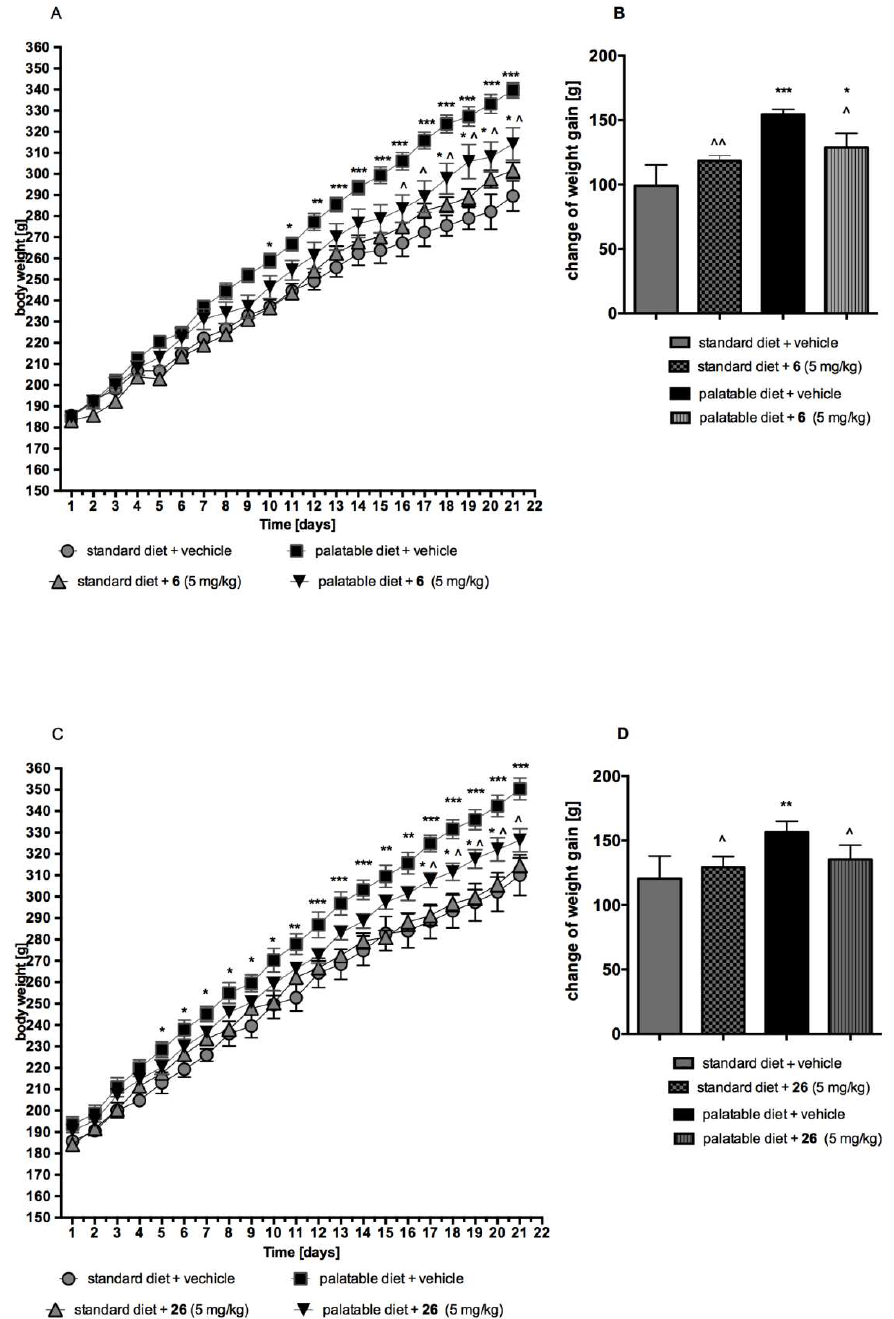
Figure 5. Influence of long-term administration of 6 or 26 on the body weight in male Wistar rats. The change in body weight in Wistar rats fed palatable diet or standard diet and in Wistar rats fed palatable diet or standard diet treated for 21 days with 6 ( A , B ) or 26 ( C , D ). Results are means ± SEM, n = 6. Multiple comparisons were performed by two-way ANOVA, Sidak post-hoc ( A , C ) or by one-way ANOVA, Sidak post-hoc ( B , D ); * p < 0.05, ** p < 0.01, *** p < 0.001 significant vs. control rats fed standard diet; ^ p < 0.05, ^^ p < 0.01 significant vs. control rats fed palatable diet.